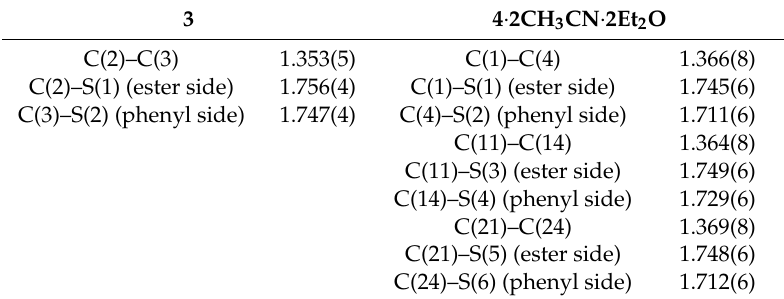
Table 2. Atom to atom distances [Å] of C = C and C − S bonds in ligand precursor 3 and complex